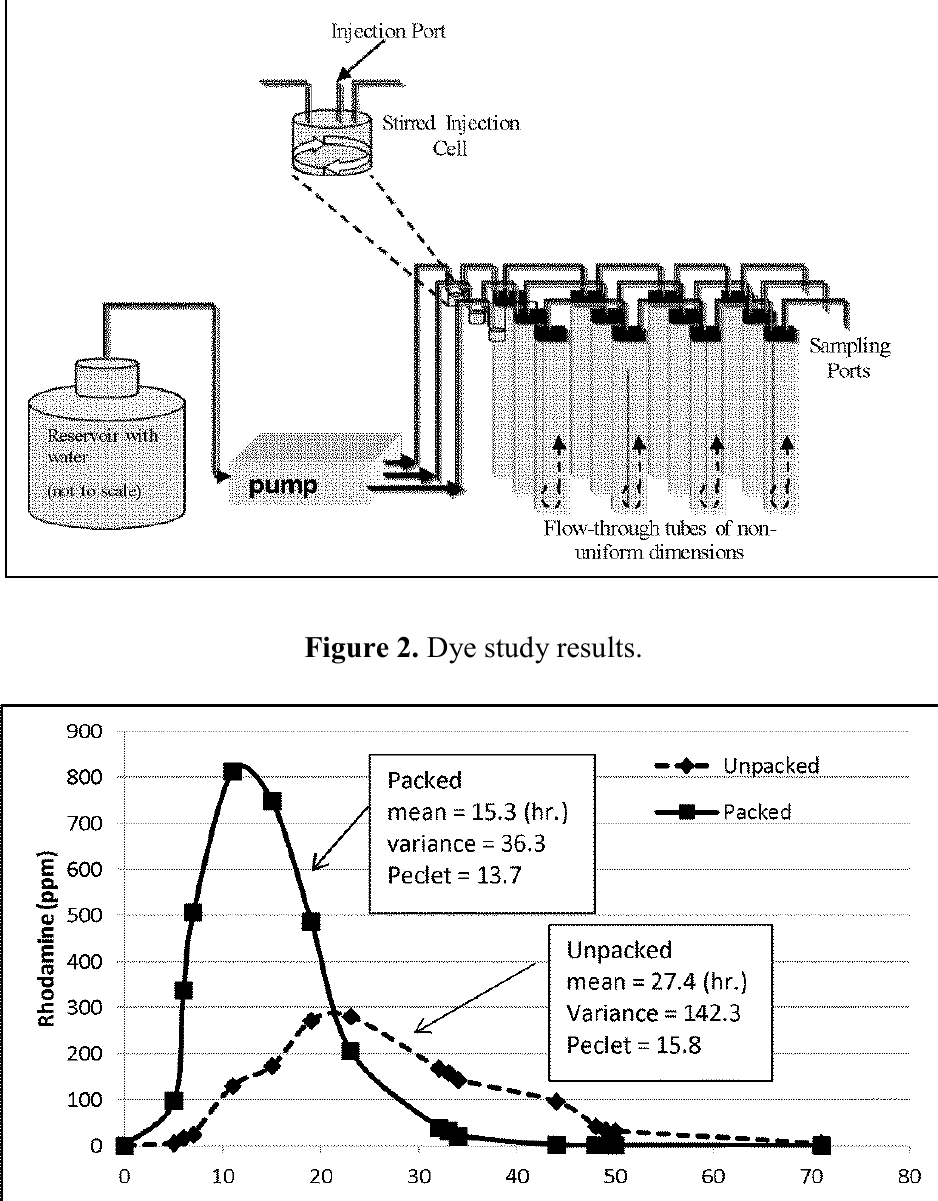
Figure 1. Schematic of flow-through microcosms.